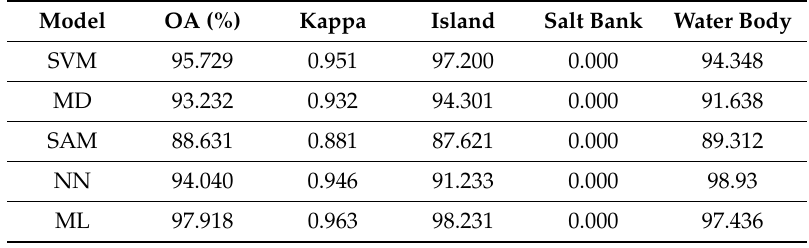
Table 2. Land area (km 2 ) by different supervised classification algorithms in 2000.